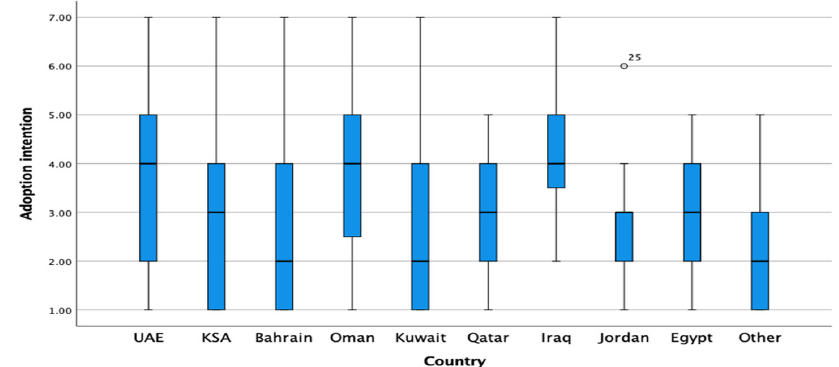
Figure 12 ARSG Adoption intention by